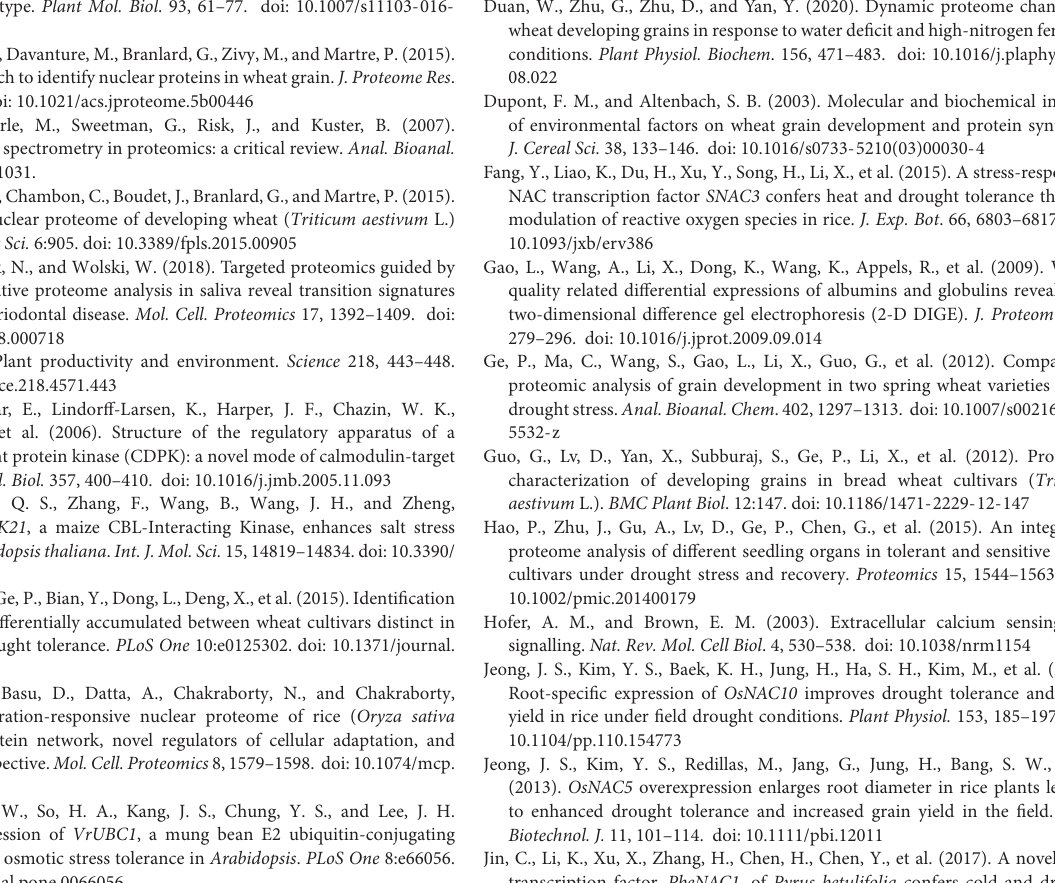
developing grains under water deficit.